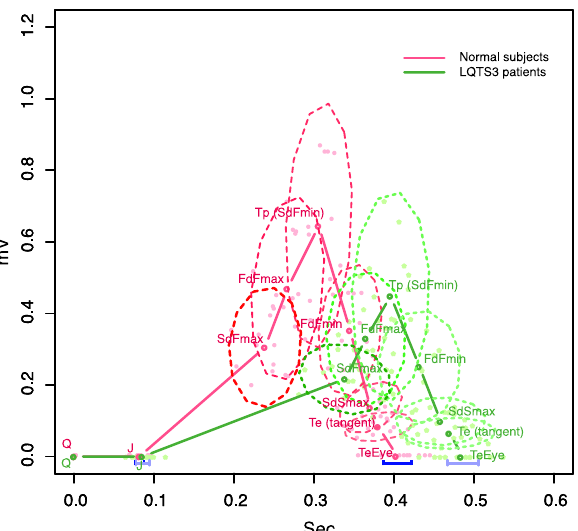
Figure 3. Simply averaged shapes of 9 landmarks of the 12 normal subjects (red) and 12 LQTS3 patients (green). Q is zero at the starting point. The x-coordinates of the landmarks were revised by Bazett correction. The abbreviations in the figure are defined in the main text of this paper. The 95% confidence intervals of the J point and TeEye are indicated by solid blue horizontal lines. The dashed ovals indicate the 95% confidence ellipses for the other landmarks. The corresponding 95% confidence ellipses for the landmarks do not overlap. The pale pink dots are the landmarks of the normal subjects, and the pale green dots are the landmarks of the LQTS3 patients. R version 4.0.2 URL https:// www.R- proje ct.